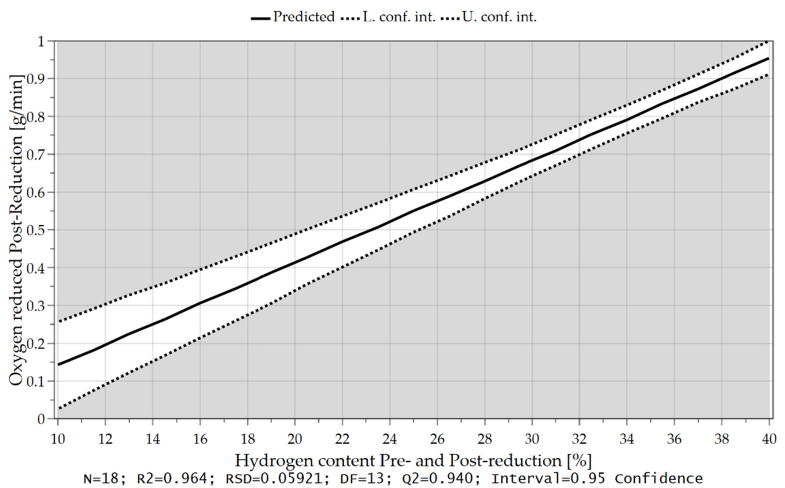
Figure 23. Oxygen removal rate in the post ‐ reduction as a function of hydrogen content during post ‐ reduction.